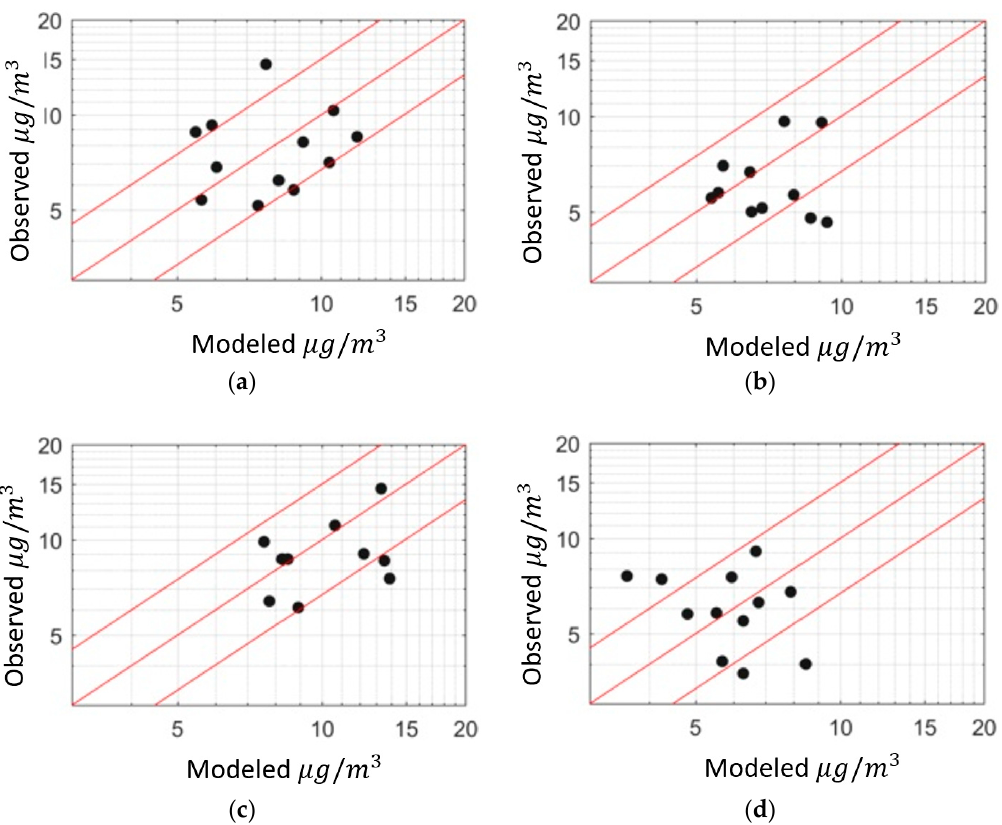
Figure 8. Model performance for different sensors for monthly averaged concentrations at ( a ) Brawley, ( b ) El Centro, ( c ) Calexico, and ( d ) Westmorland.